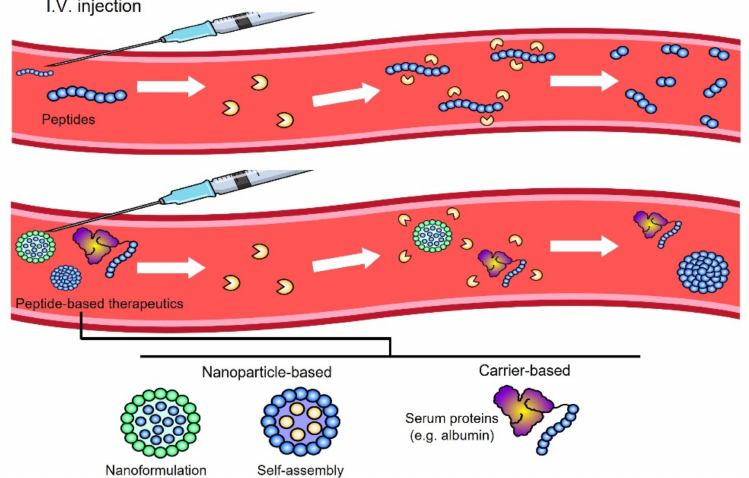
Figure 1. Proteolytic degradation of peptide products in the blood is considered a critical problem for clinical use. Peptide-based therapeutics such as peptide-based nanoparticles or carrier-utilizing peptide conjugates may stabilize peptide molecules in the circulatory system in